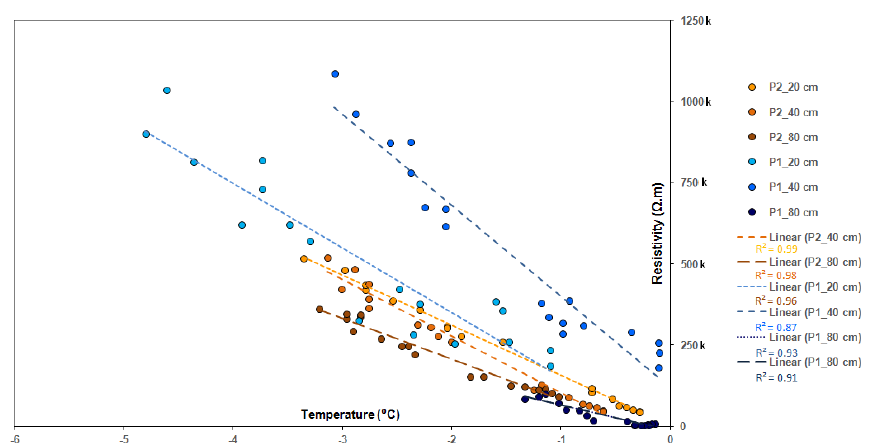
Figure 10. Resistivity values at the borehole location against borehole temperatures in S 3 , 3 during the seasonal active layer freezing in April and May (P1) and thawing in October (P2).